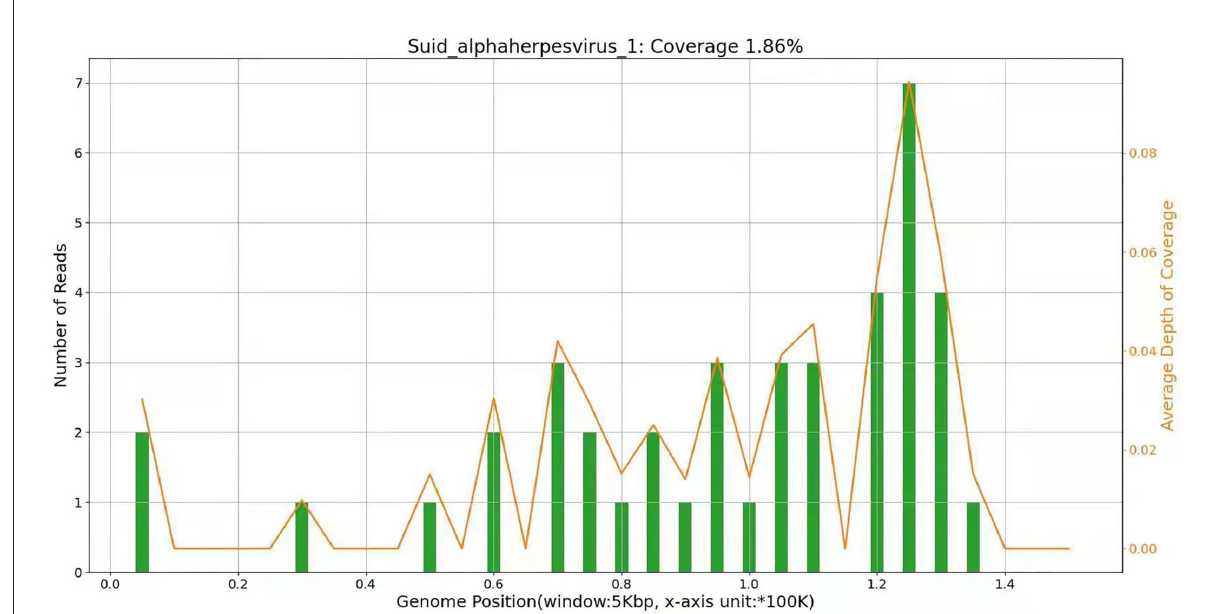
FIGURE1 On 15 April, NGS results of cerebrospinal fluid showed that the pathogen of encephalitis in this patient was pseudorabies virus, and the genome coverage rate was 1.86%.